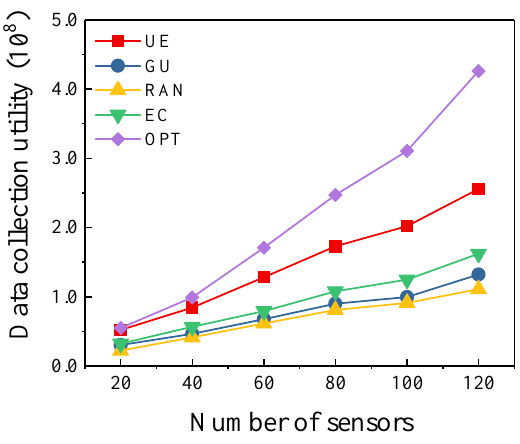
Figure 2. Different Number of Sensors.